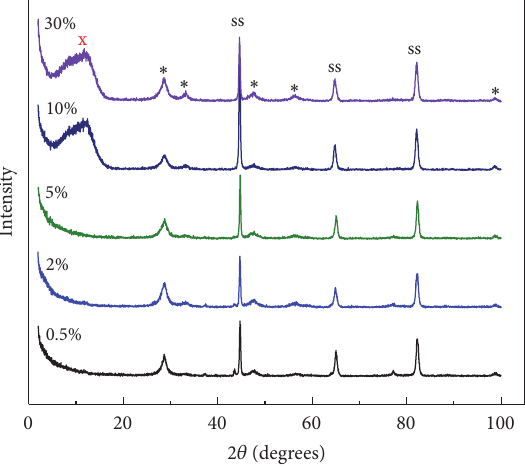
Figure 2: X-ray diffraction patterns of (a) CeO 2 powder and (b) Na- montmorillonite powder.